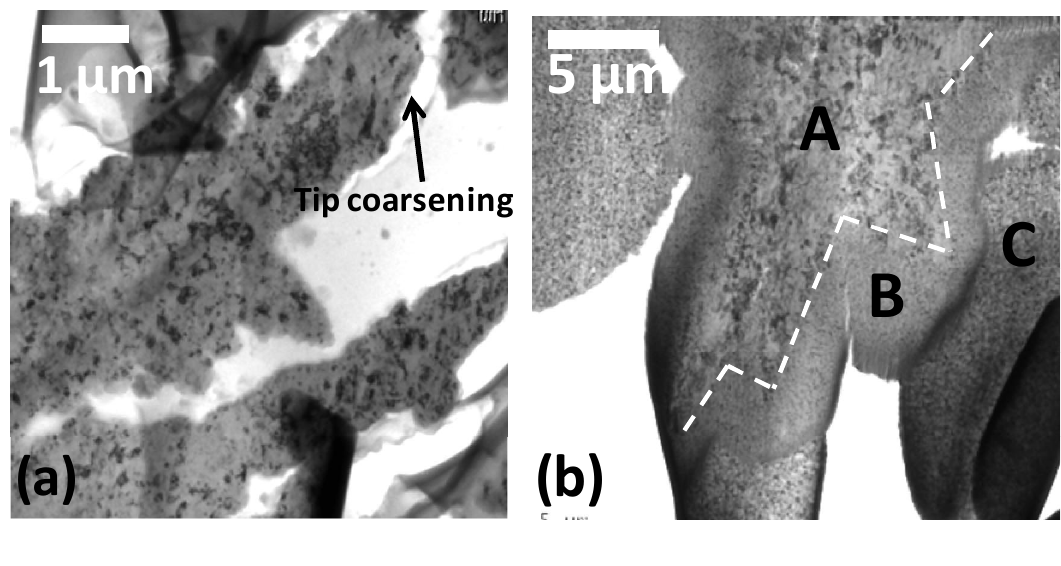
Figure 3. Low magnification bright field TEM image of: ( a ) feather-like morphology with coarsening at tips indicated by arrow; ( b ) dendrite with morphological evolution from feather-like (A) to smooth (B) indicated by dashed line and rough (C)